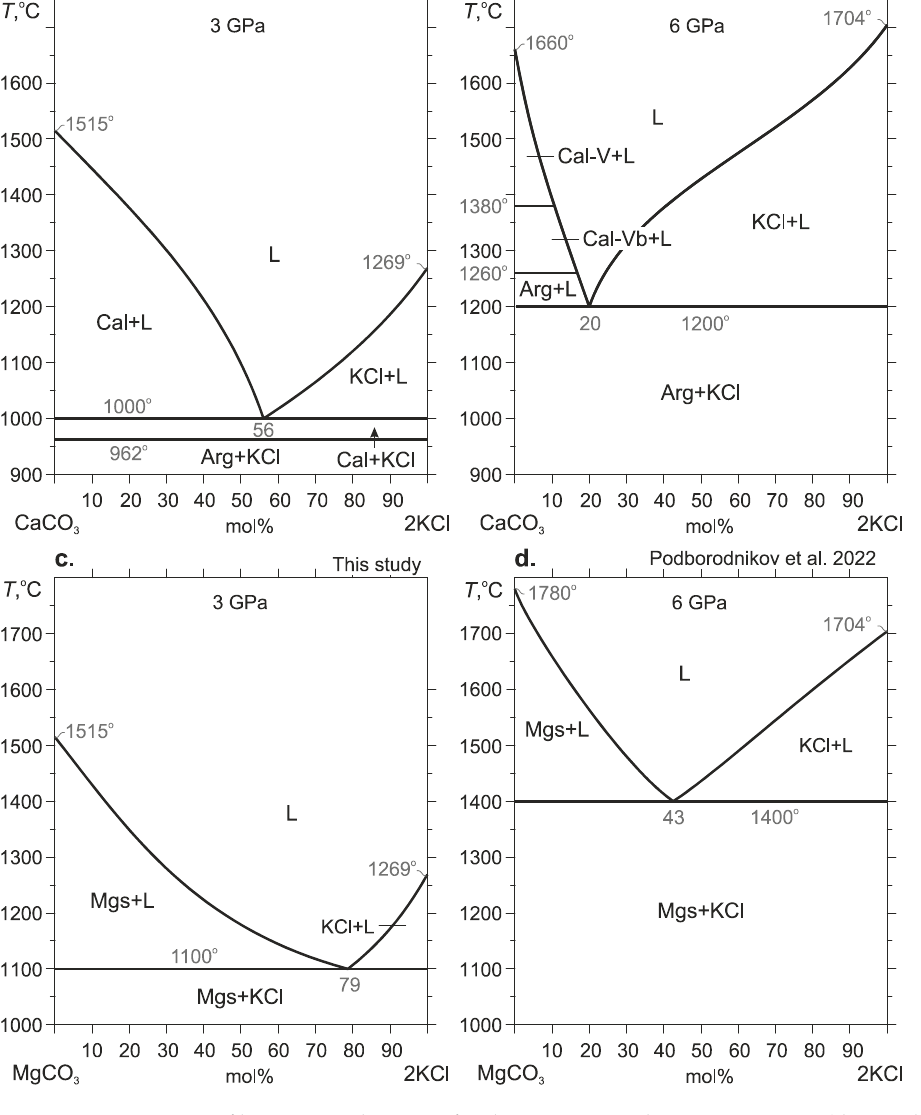
Figure 7. Comparison of binary T-X diagrams for the systems: KCl–CaCO 3 at 3 GPa (this study) ( a ), KCl–CaCO 3 at 6 GPa [33] ( b ), KCl–MgCO 3 at 3 GPa (this study) ( c ), KCl–MgCO 3 at 6 GPa [33] ( d ).